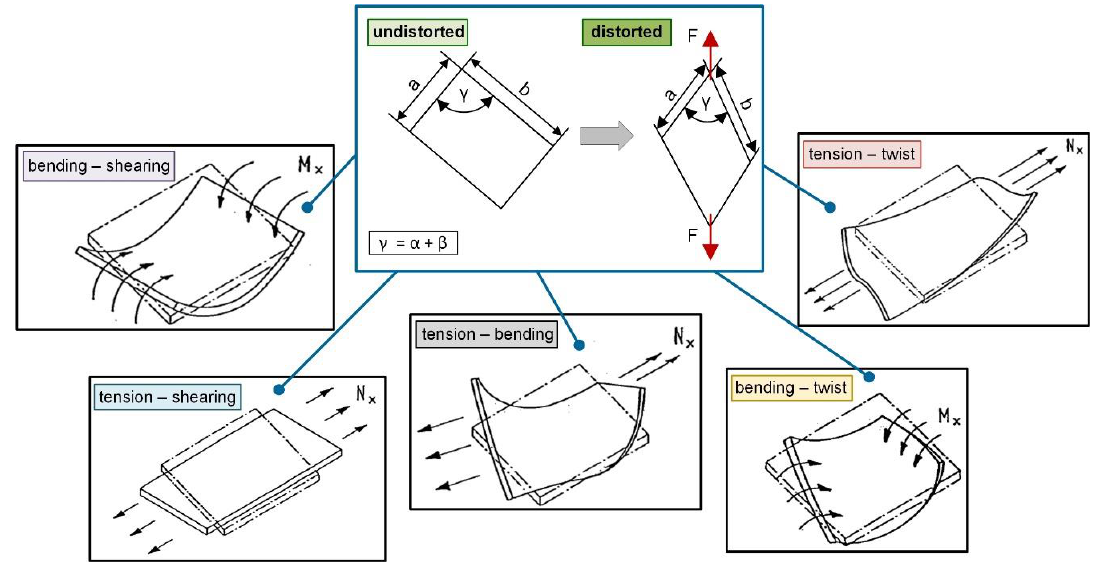
Figure 1. Schematic illustration of distortion processes (undistorted versus distorted) and corresponding deformation possibilities of bending, shearing, twist or tension depending on the load-coupling related to the material’s law for fiber reinforced composites